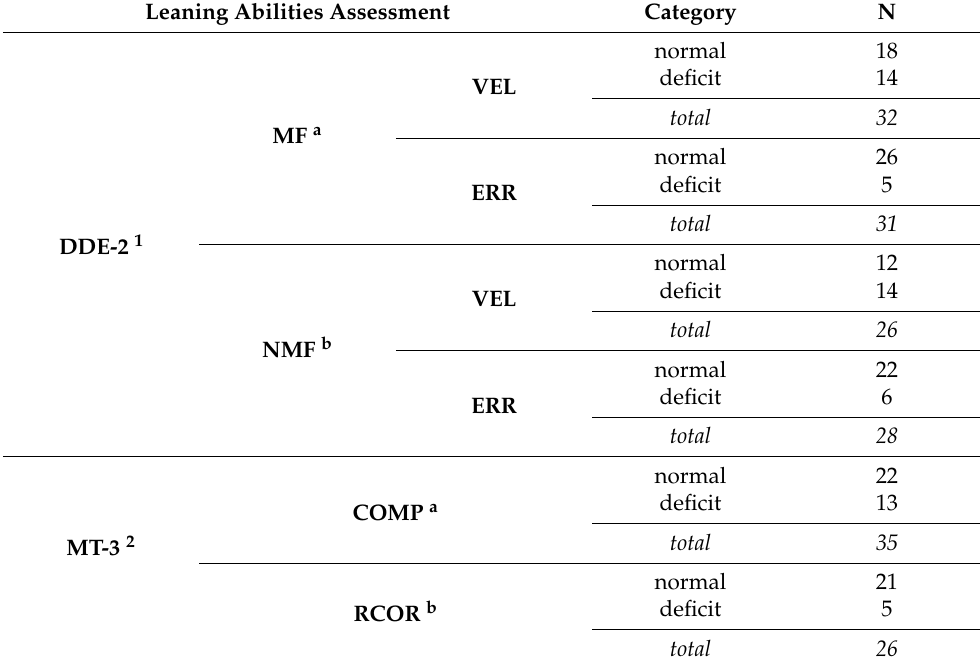
Table 5. Learning abilities assessment. N indicates the number of subjects who performed the test or had interpretable